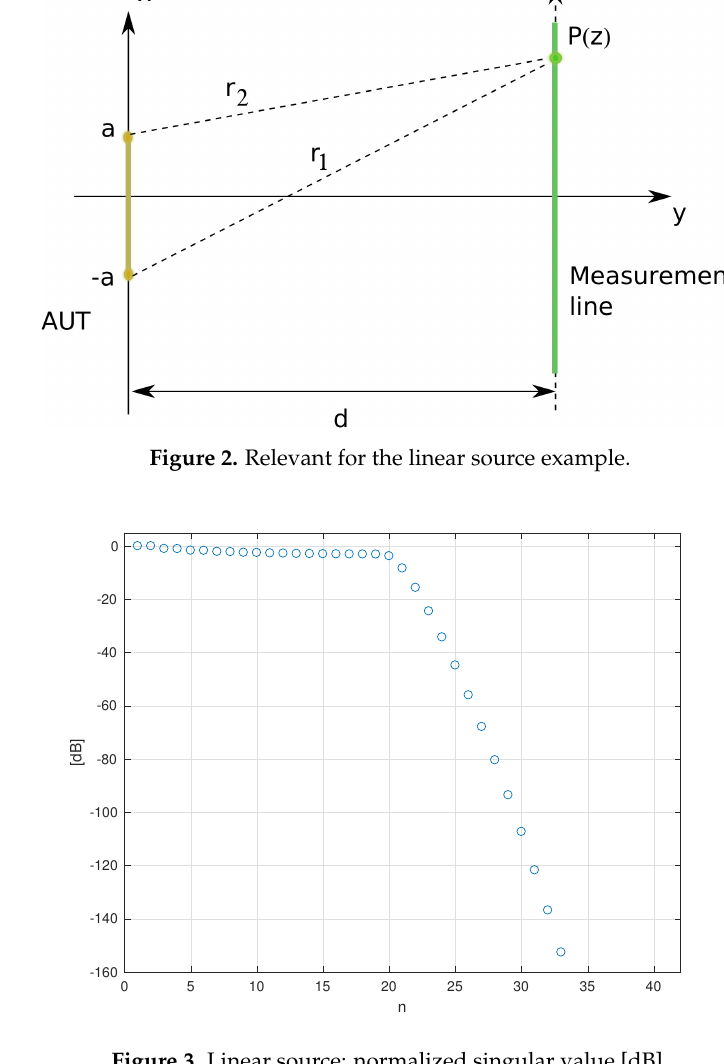
Figure 3. Linear source: normalized singular value [dB].